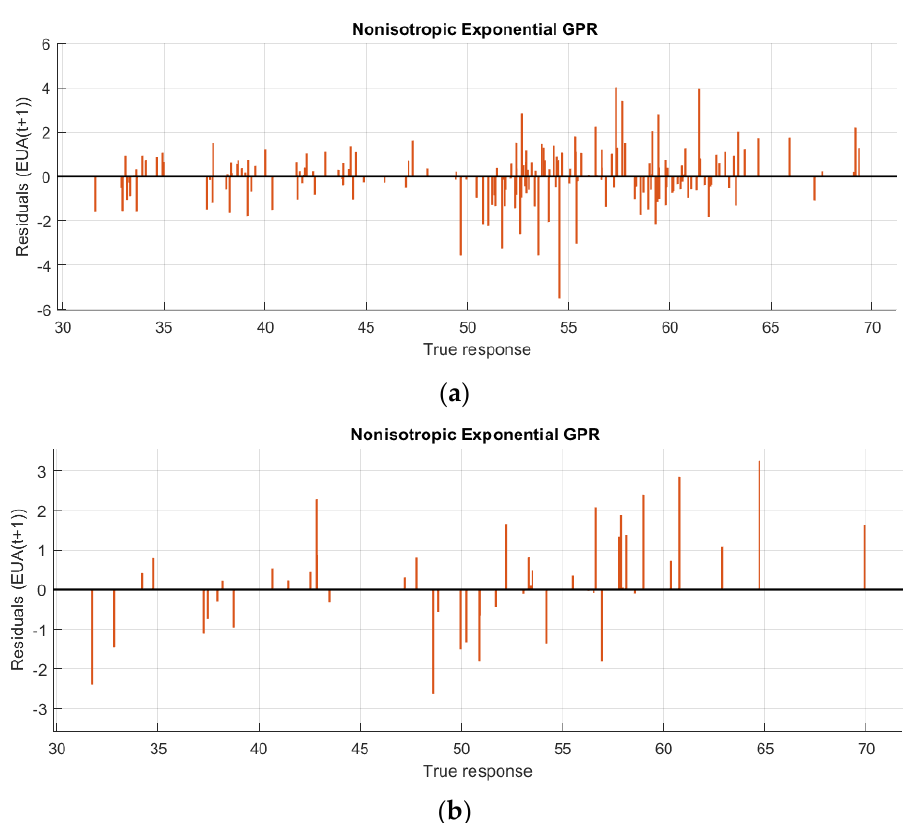
Figure 13. Dependence between residuals and true responses using Non-isotropic Exponential GPR for ( a ) train data and ( b ) test data.